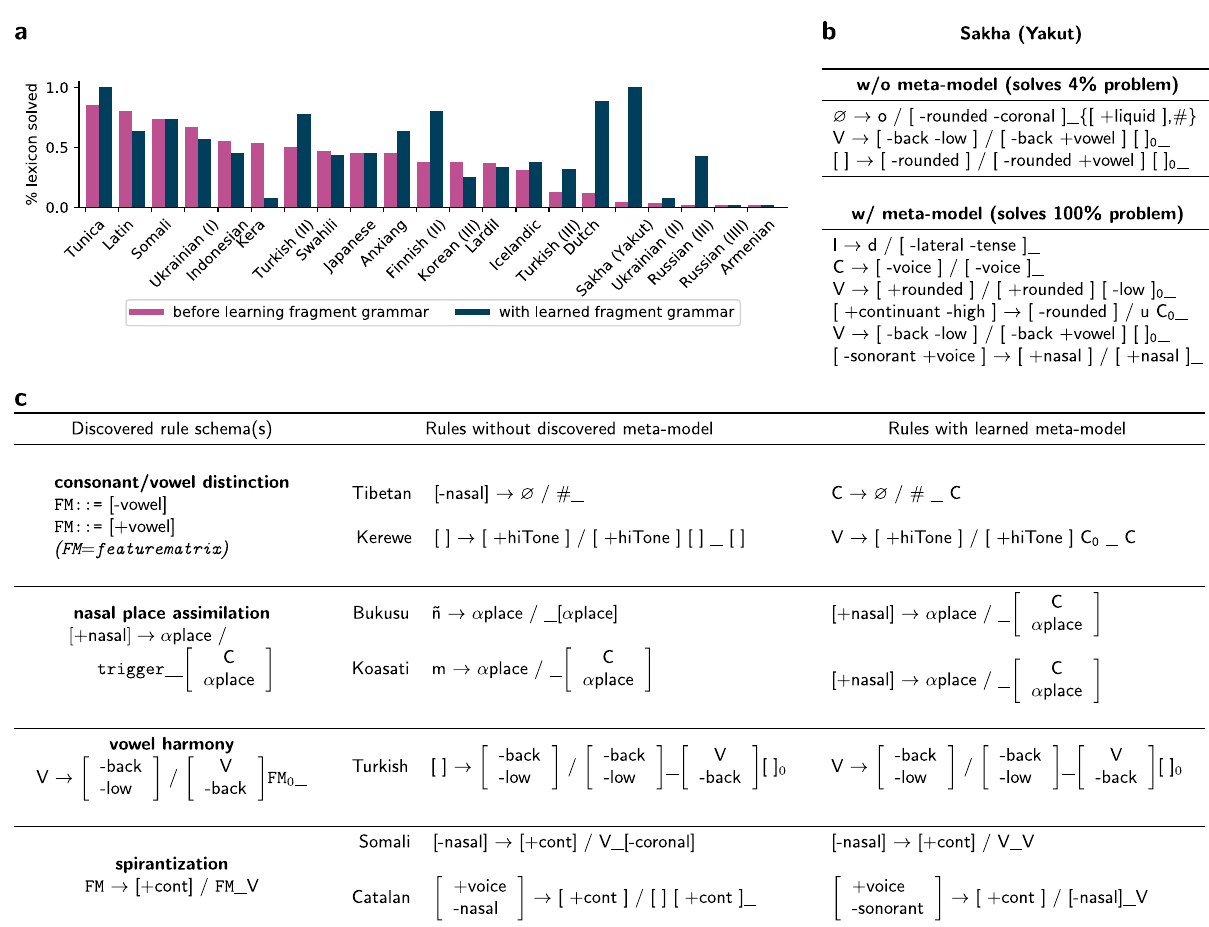
Fig. 8 | Discovering and using a cross-language metatheory. a Re-solving the hardesttextbookproblemsusingthelearnedfragmentgrammarmetatheoryleads to an average of 31% more of the problem being solved. b illustrates a case where these discovered tendencies allow the model to fi nd a set of six interacting rules solvingtheentiretyofanunusuallycomplexproblem. c Themetatheorycomprises rule schemas that are human understandable and often correspond to motifs previously identi fi ed within linguistics. Left column shows four out of 21 induced rule schemas (Supplementary Fig. 6), which encode cross-language